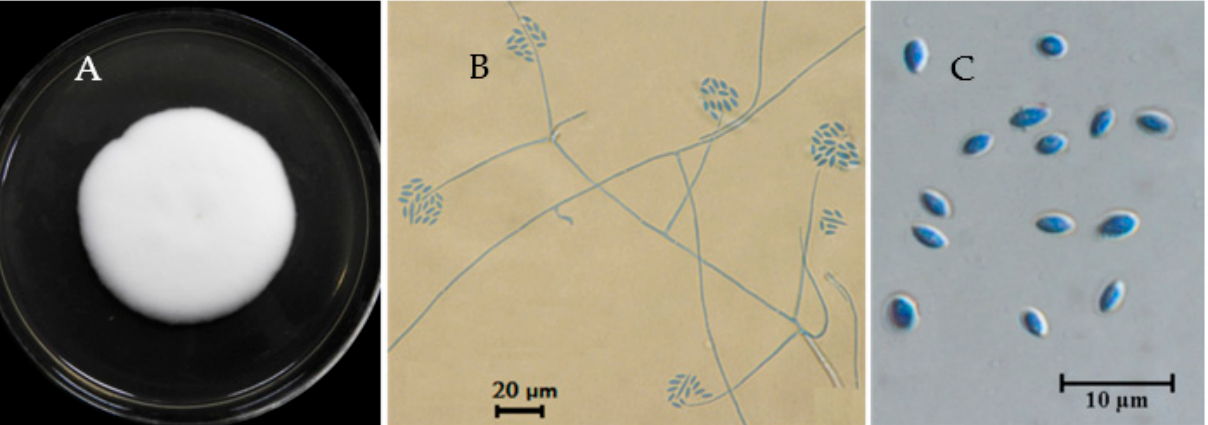
Figure 1. Morphology of Simplicillium lamellicola JC-1. ( A ) A colony with a white villiform appearance (PDA, 20 °C, 16 d) in a Petri dish (9 cm in diameter); ( B ) solitary and slender conidiophores (phialides) on hyphae with conidial masses at the apex (stained with cotton blue); ( C ) unicellular and oval-shaped conidia (stained with cotton blue).